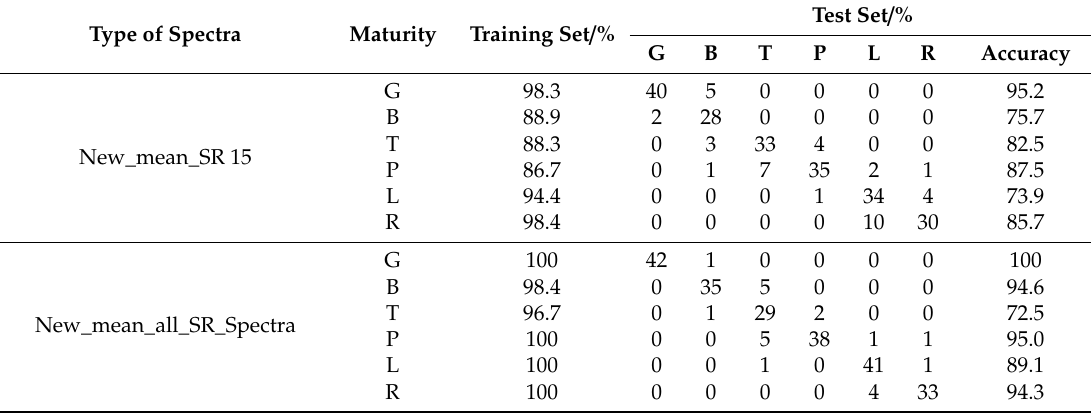
Table 5. Classification results for the six maturity of tomatoes by using Support Vector Machine discriminant analysis for new mean_SR 15 and new mean_all_SR